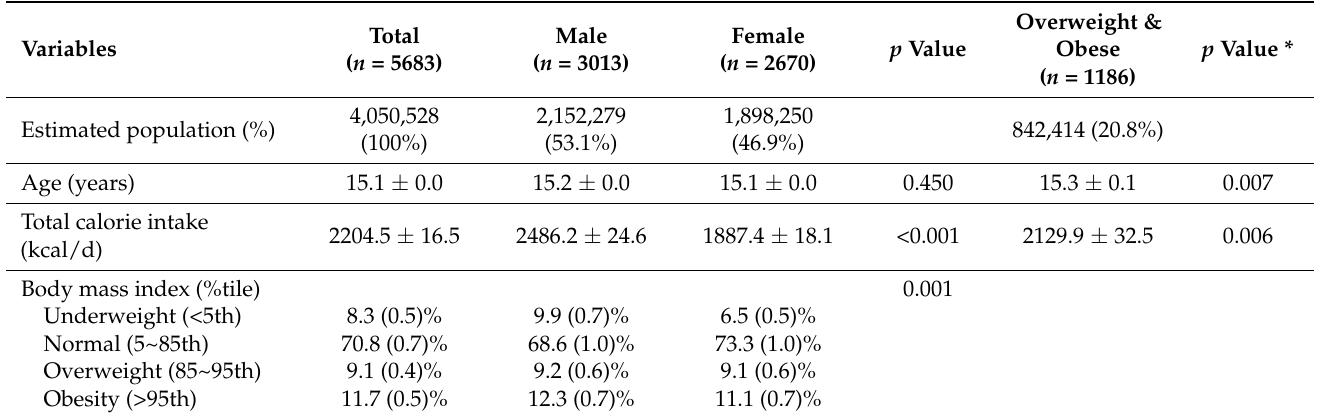
Table 1. Socio-demographic characteristics and health conditions of the study